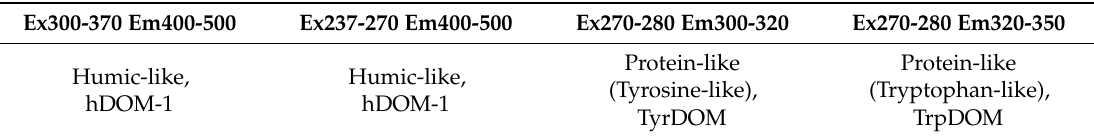
Table 1. Summary and naming of the fluorescence peaks used for dissolved organic matter (DOM) molecular characterization [35,36].